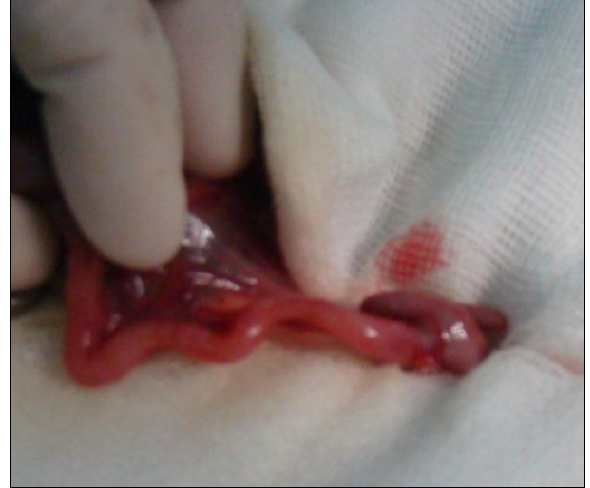
Figure 1 : Collapsed